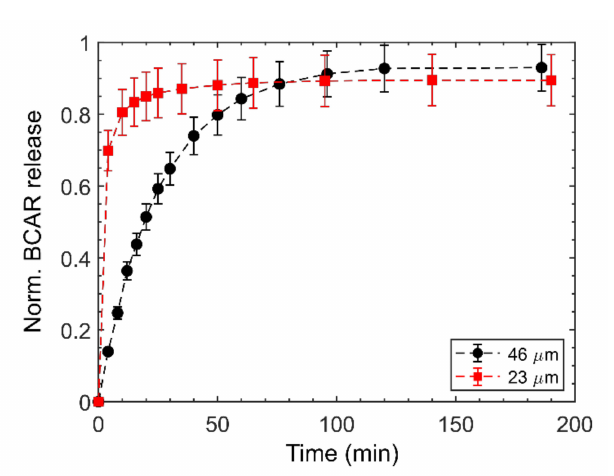
Figure 7. Experimental release curves fitted with the 1st order kinetic model for two PSi-A samples of di ff erent thickness. Error bars are the SD over three di ff erent releases from three di ff erent PSi